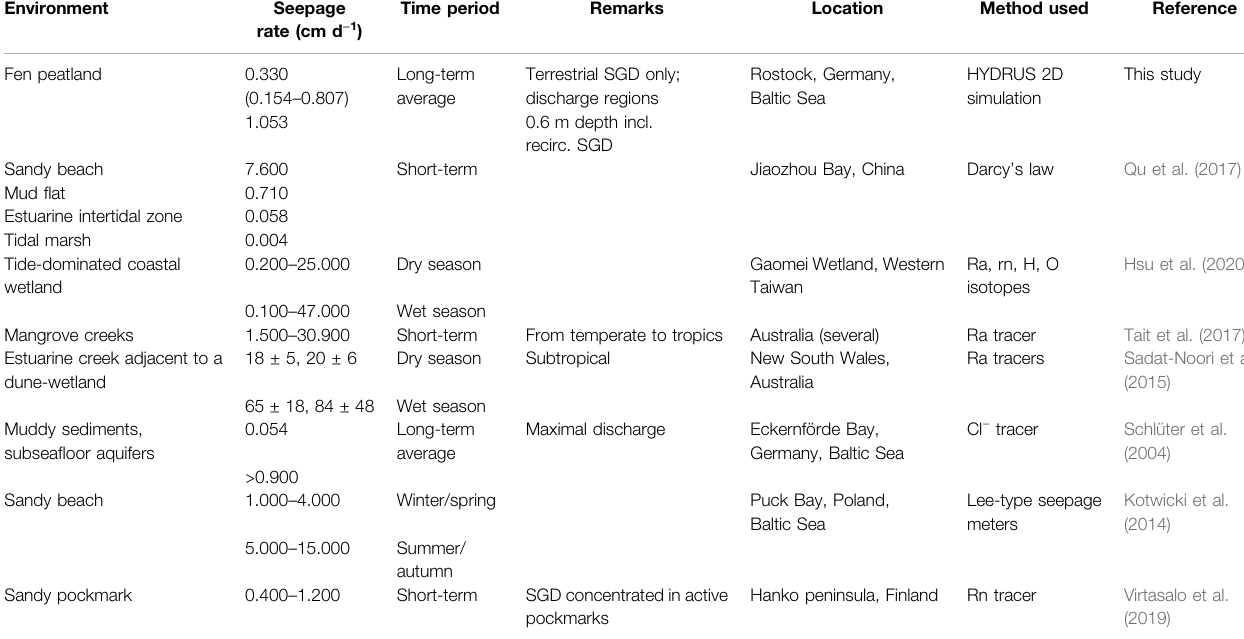
TABLE 4 | Seepage rates of SGD studies from wetland environments and different locations in the Baltic Sea.